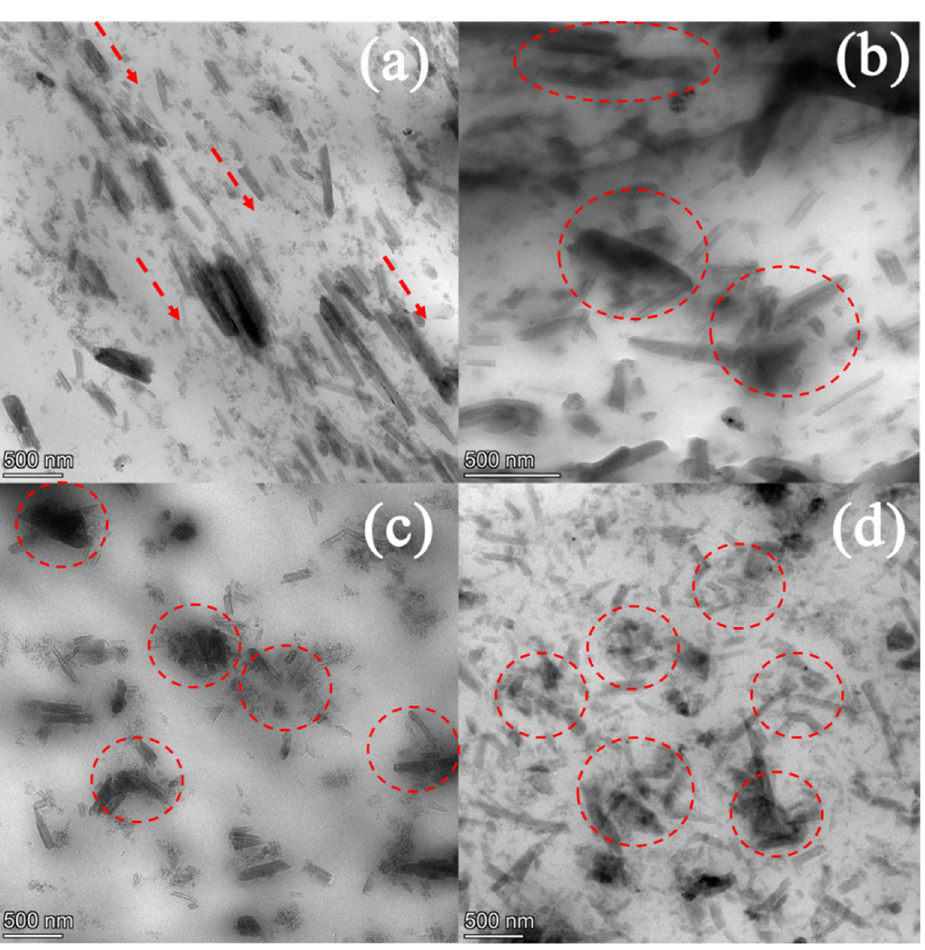
Figure 5. TEM images of PEO − 20%LiCF 3 SO 3 − 5%HNT ( a ) Non − US, ( b ) US 15 min, ( c ) US 30 min ( d ) US 60 min.